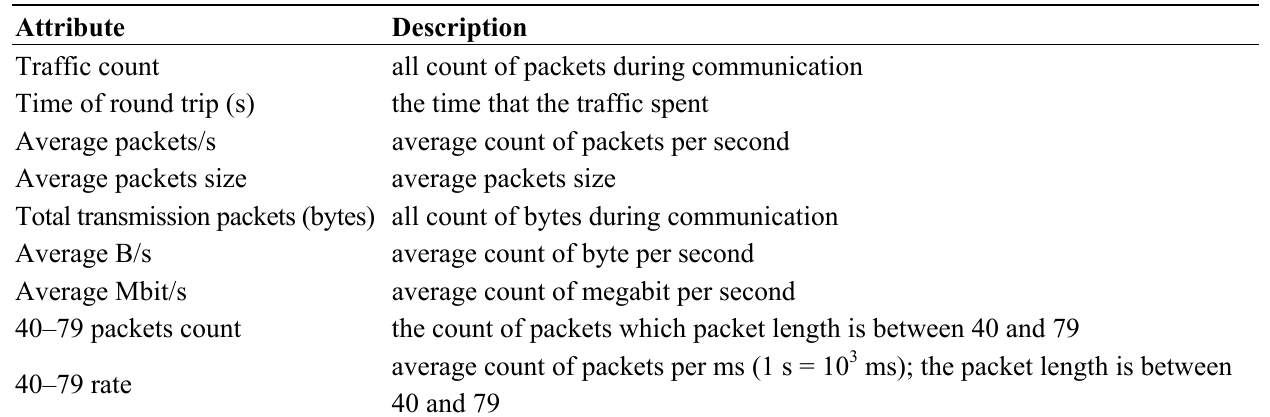
Table 1 details the selected attributes after analysis of the SYN flood attack. Table 1. SYN flood